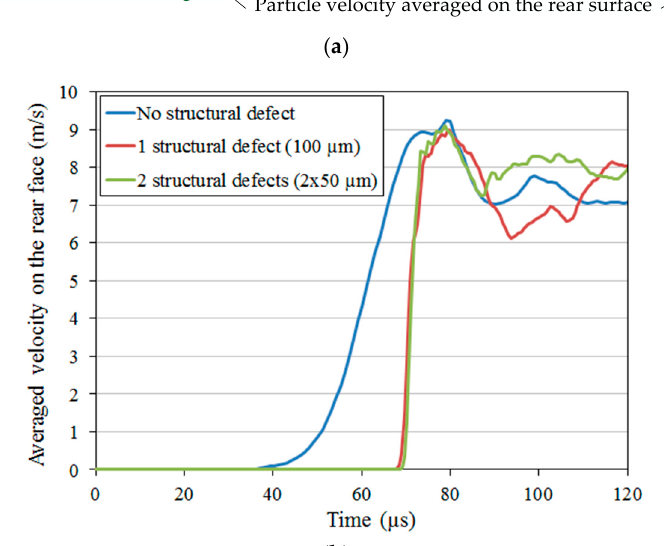
Figure 14. Numerical simulations of spalling tests with the KST-DFH model. ( a ) Considered position of structural defects in the second and third numerical simulations. ( b ) Particle velocity averaged on the rear face without, with one, or two structural defects.